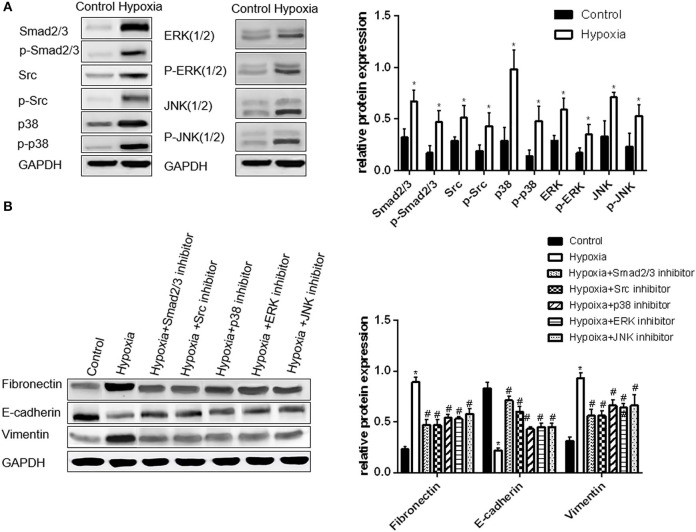
Activation of Smad2/3, Src, p38, ERK, and JNK is important in hypoxia-induced EMT in A549 cells. (A) Smad2/3, Src, p38, ERK, JNK, and their phosphorylated forms were examined by Western blot analysis (left). GAPDH was used as internal control. The protein relative value (GAPDH) is plotted in the right panel (mean ± SD in three separate experiments). *P < 0.05, compared with A549 cells in the normal oxygen environments, the Smad2/3, Src, and MAPK proteins of A549 cells are highly regulated and activated in hypoxia environments. (B) EMT markers were examined by Western blot analysis (left). GAPDH was used as internal control. The protein relative value (GAPDH) is plotted in the right panel (mean ± SD in three separate experiments). *P < 0.05, compared with A549 cells in the normal oxygen environments, the EMT process of A549 cells under hypoxia is activated; #P < 0.05, compared with A549 cells in the hypoxia environments, the EMT process of A549 cells under hypoxia is inhibited separately by Smad2/3, Src, p38, ERK, and JNK inhibitors. The expression levels of Fibronectin and Vimentin decrease, and that of E-cadherin increases.